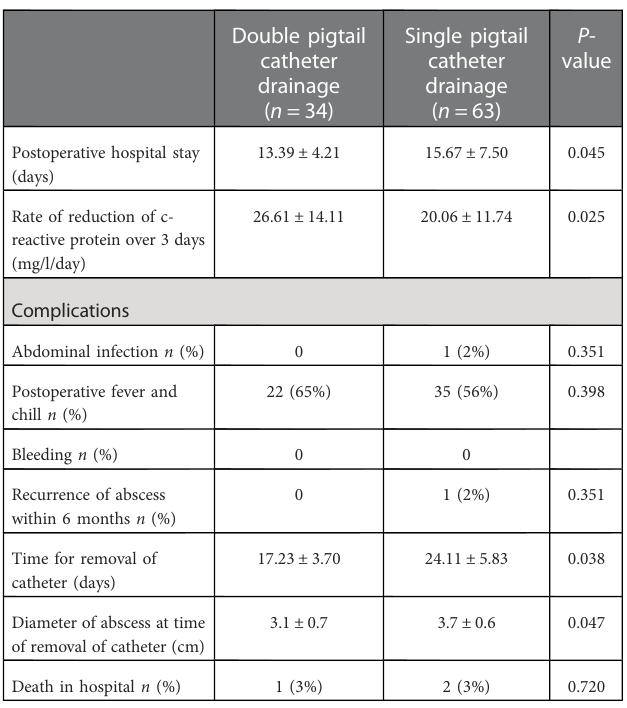
TABLE 4 Comparison of the postoperative conditions between the two groups.